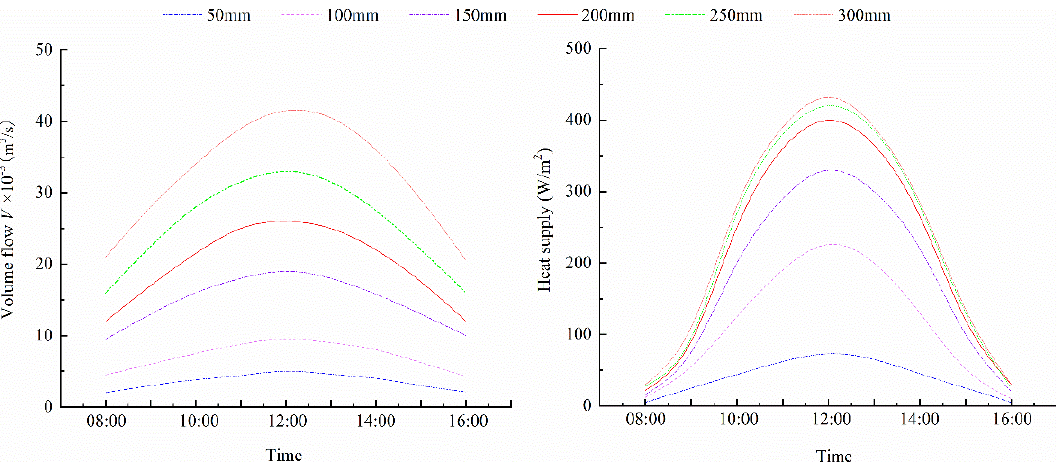
Figure 16. Effect of vent size on volume flow and heat gain of the solar wall.